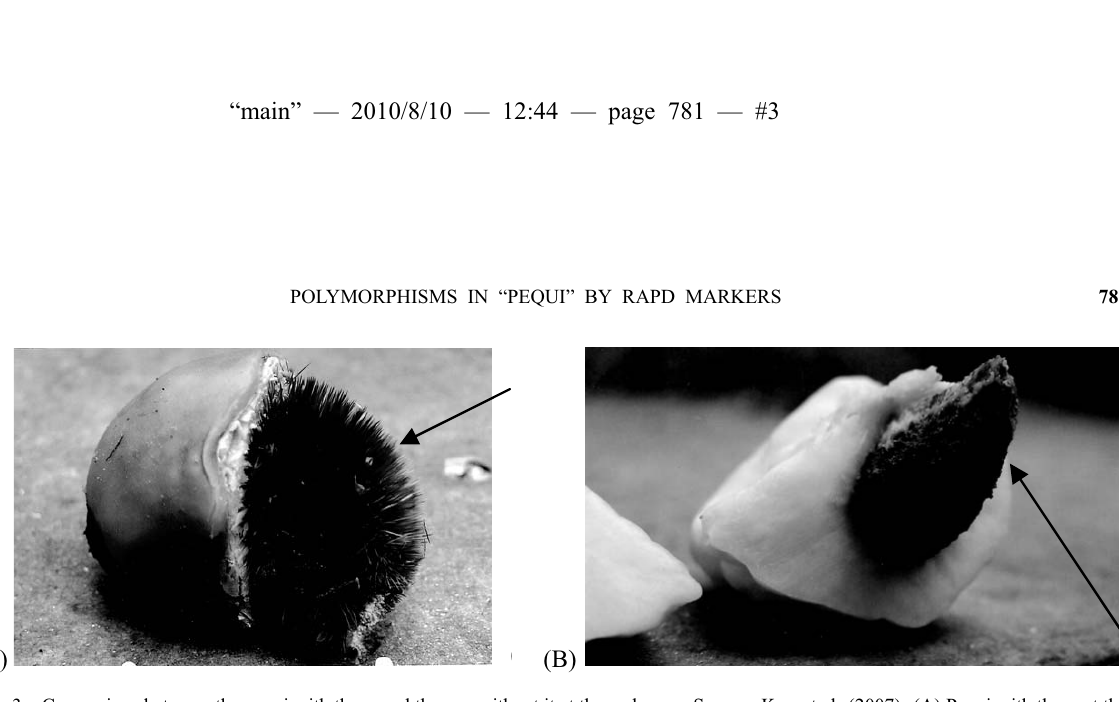
Fig. 3 – Comparison between the pequi with thorn and the one without it at the endocarp. Source: Kerr et al. (2007). (A) Pequi with thorn at the endocarp. Selected fruit showing the endocarp full of little thorns. (B) Pequi without thorn at the endocarp. Selected fruit showing the endocarp without